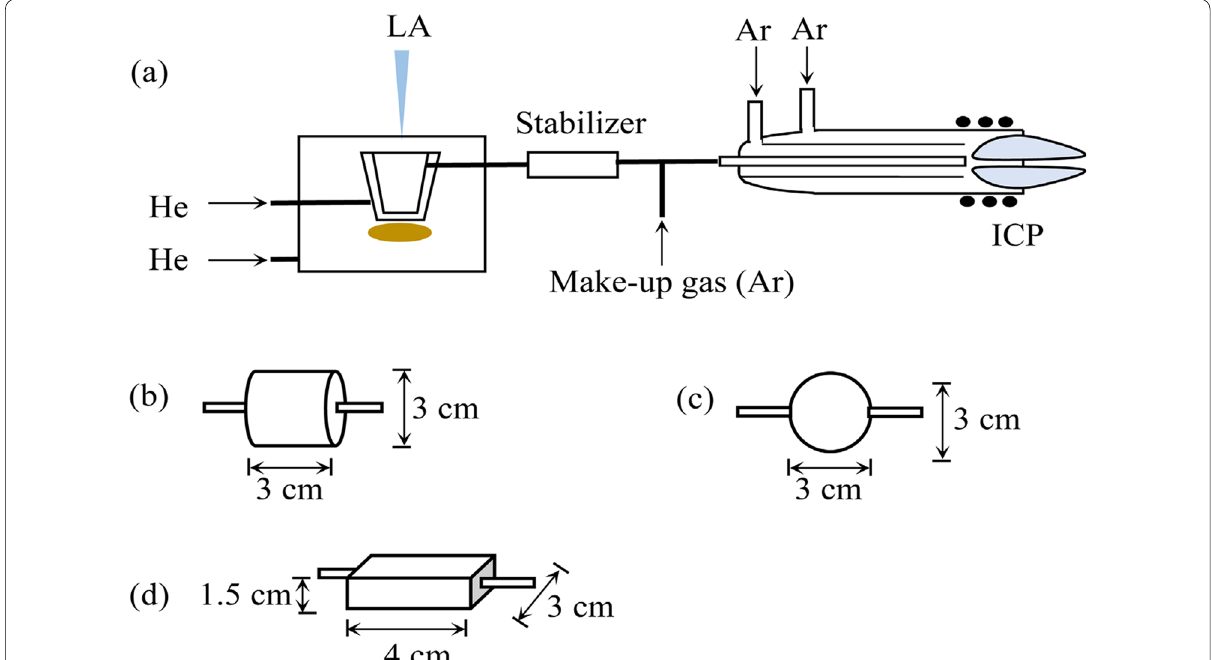
Fig. 1 Schematic diagram of the utilized LA-ICP-QMS system and the studied stabilizers. a Depicted the connection of signal stabilizer with the LA-ICP-QMS system. b – d showed the cylinder, ball and cubic shape stabilizers. Here 21.2 mL of cylinder stabilizer was shown as a representative of cylinder